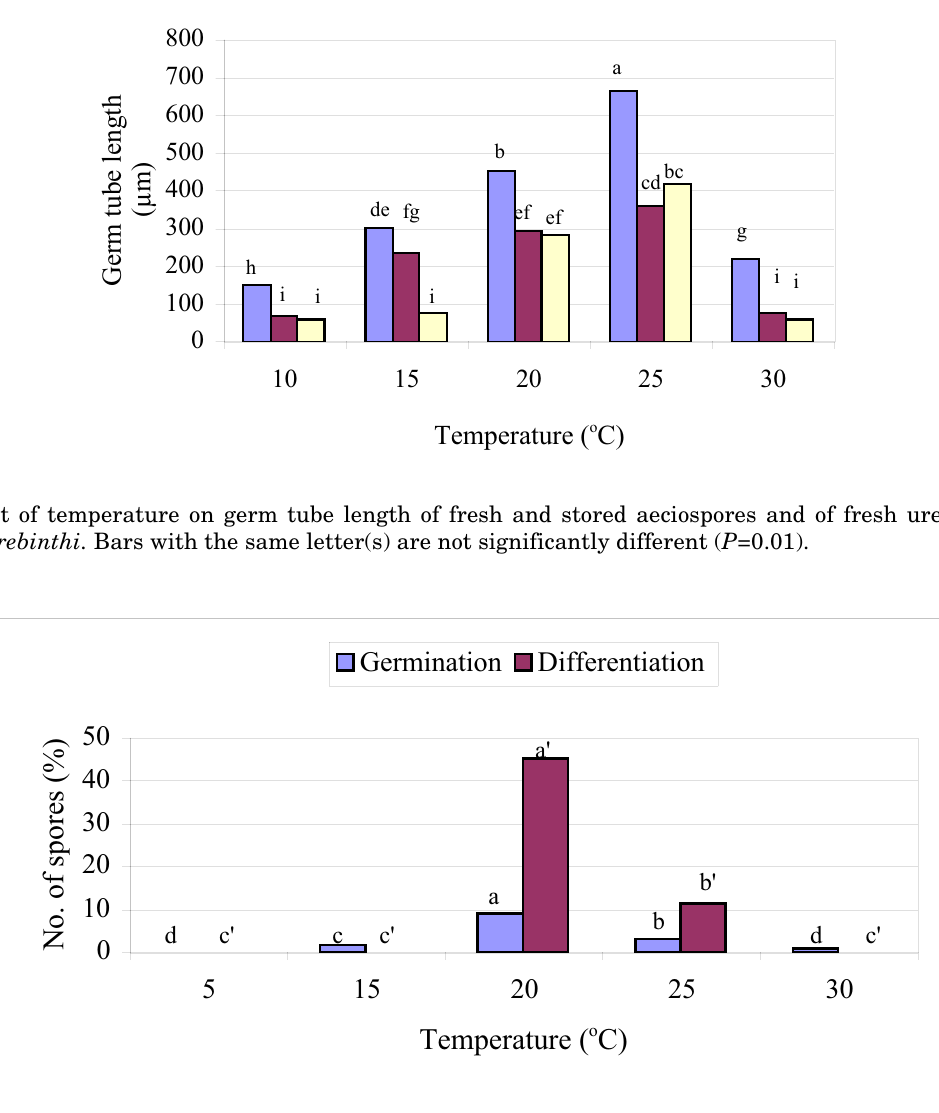
Fig. 3. Effect of temperature on teliospore germination and basidiospore differentiation of Pileolaria terebinthi. Bars with the same letter(s) are not significantly different ( P